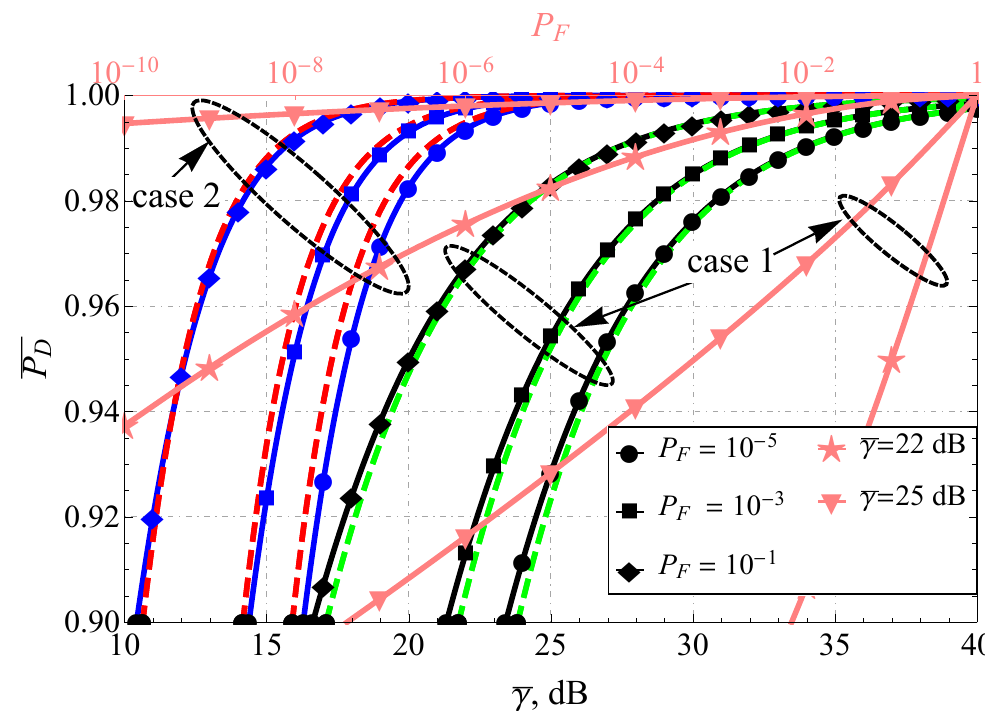
Figure 1. P FB D comparison for various P D and u = 2.2: black lines (case 1)— κ = 0.1, m = 2, µ = 1, η = 0.1, ρ 2 = 0.1, blue lines (case 2)— κ = 1, m = 2, µ = 2, η = 10, ρ 2 = 0.1, dashed red and green lines—proposed approximations.